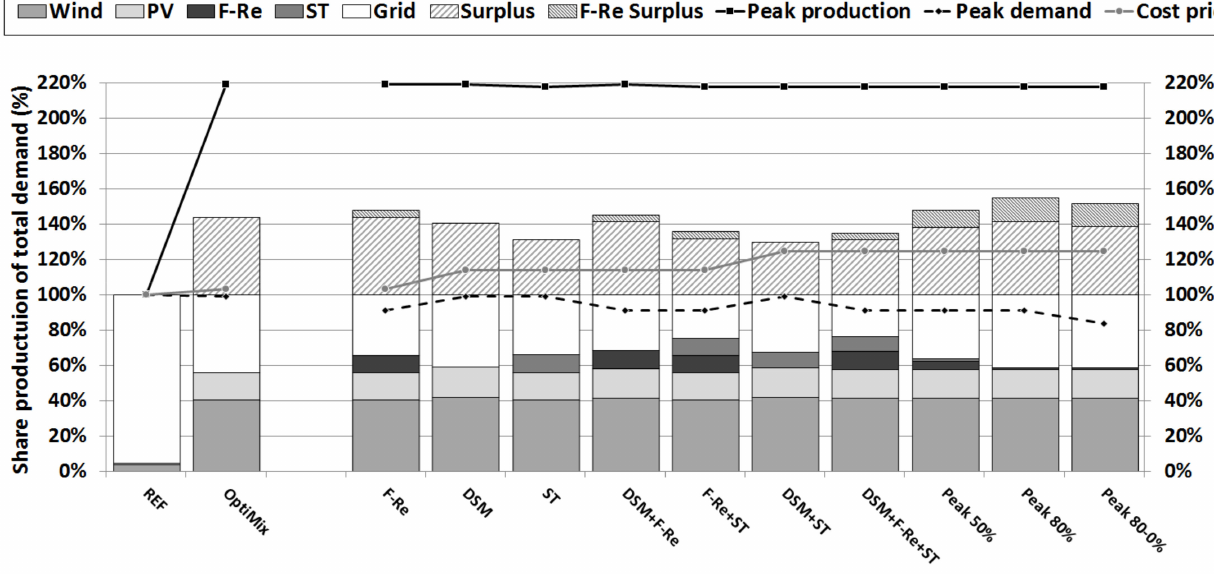
Figure A9. Main yearly results from the renewable integration and peak shaving scenarios.